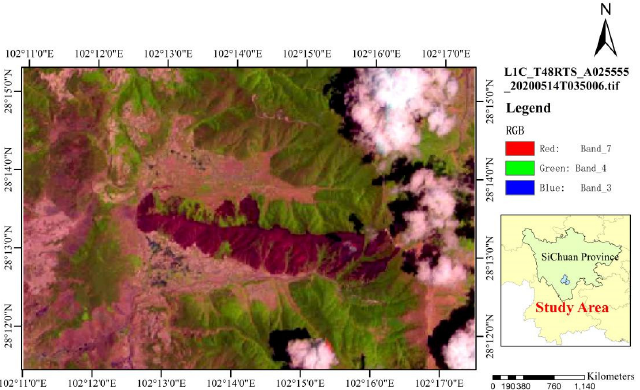
Figure 3. Mianning forest fire area, 2020.